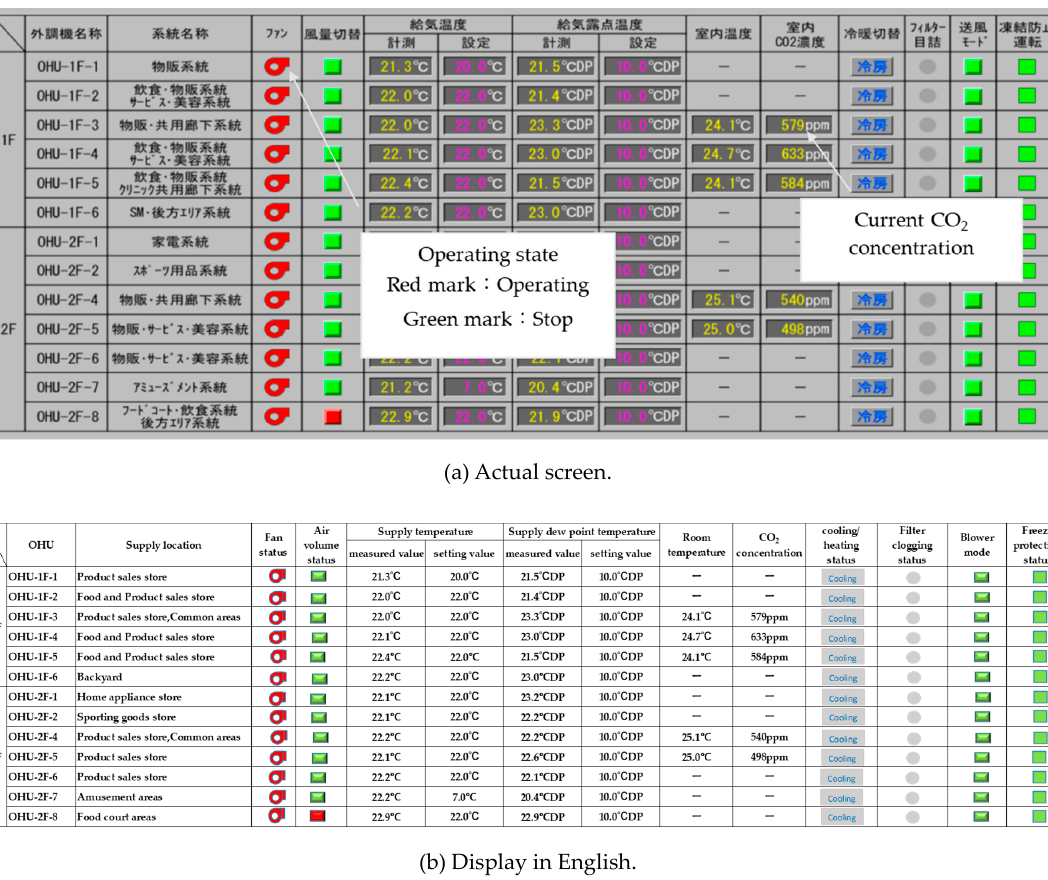
Figure 5. BAS (Building automation System) screenshot.